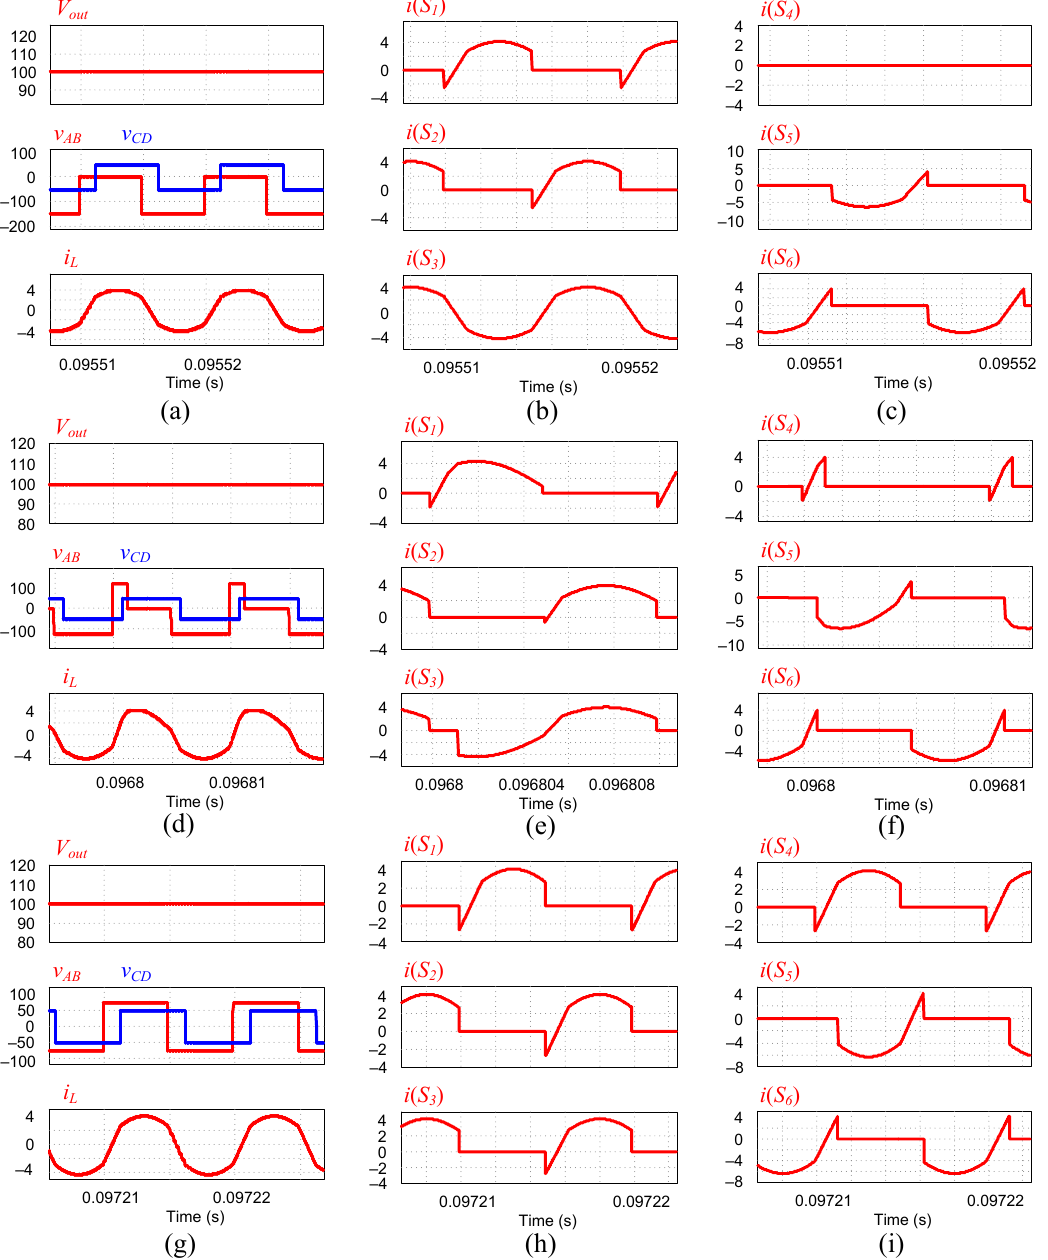
Figure 11. Simulation results of forward mode with different voltage gain M : ( a – c ) M = 0.5; ( d – f ) M = 0.6; ( g – i ) M =